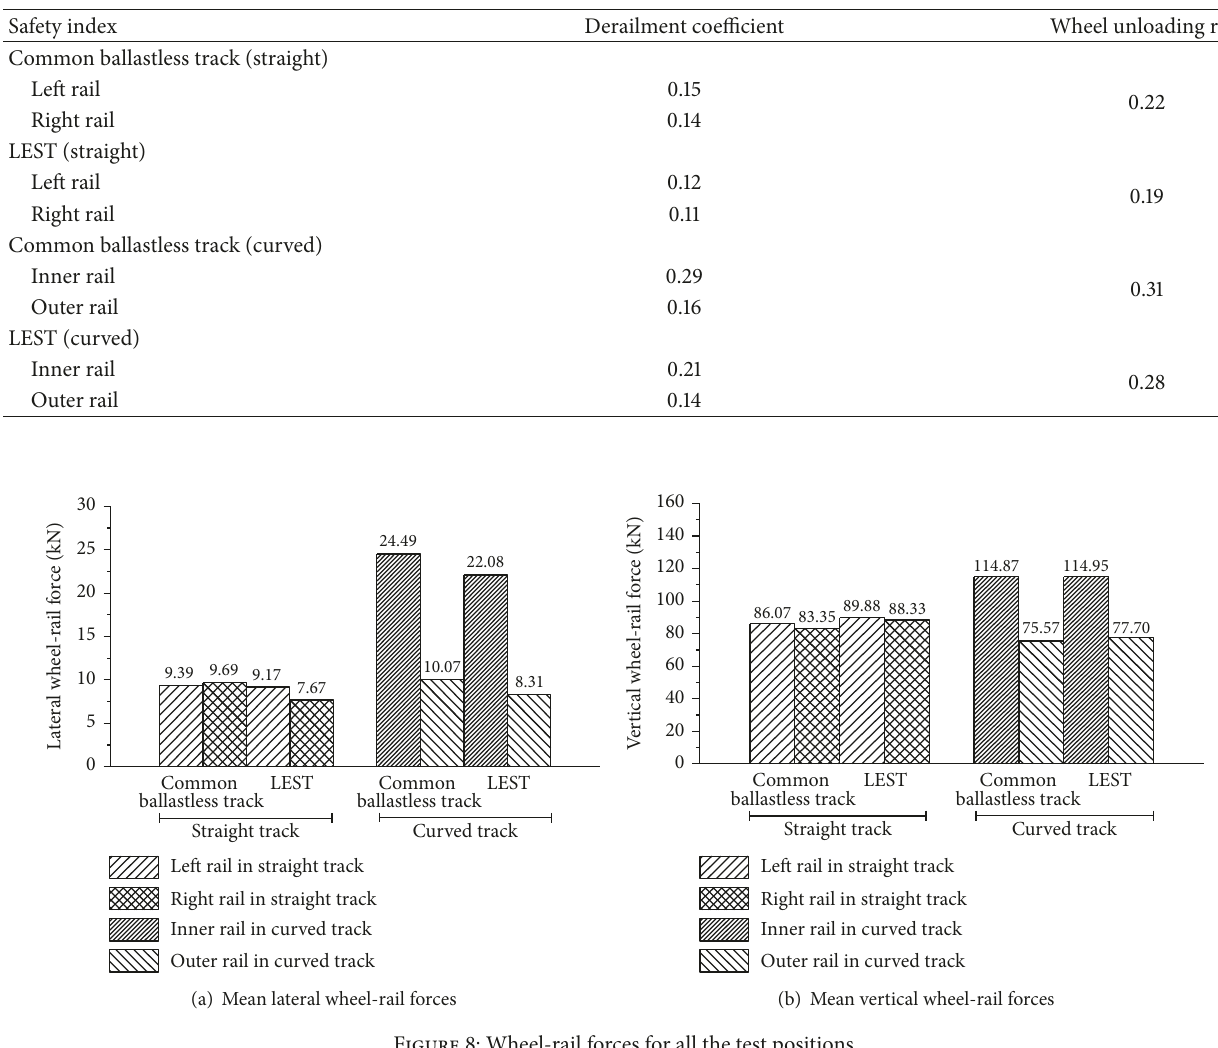
Figure 8: Wheel-rail forces for all the test